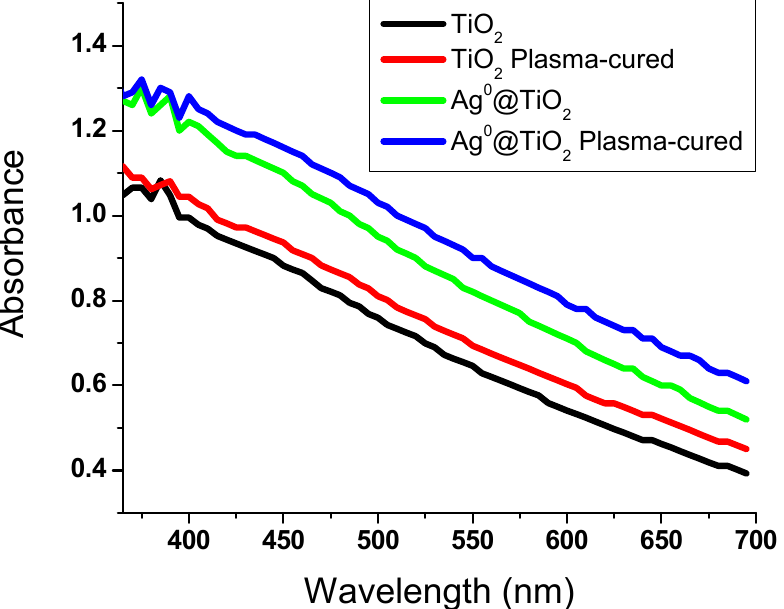
Figure 3. UV/Vis absorption spectral curves of the prepared composites coated onto viscose fibers.